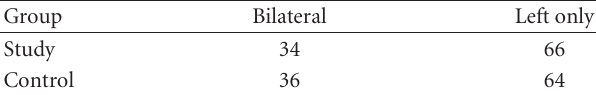
Table 2: Lateralization of varicocele in study and control